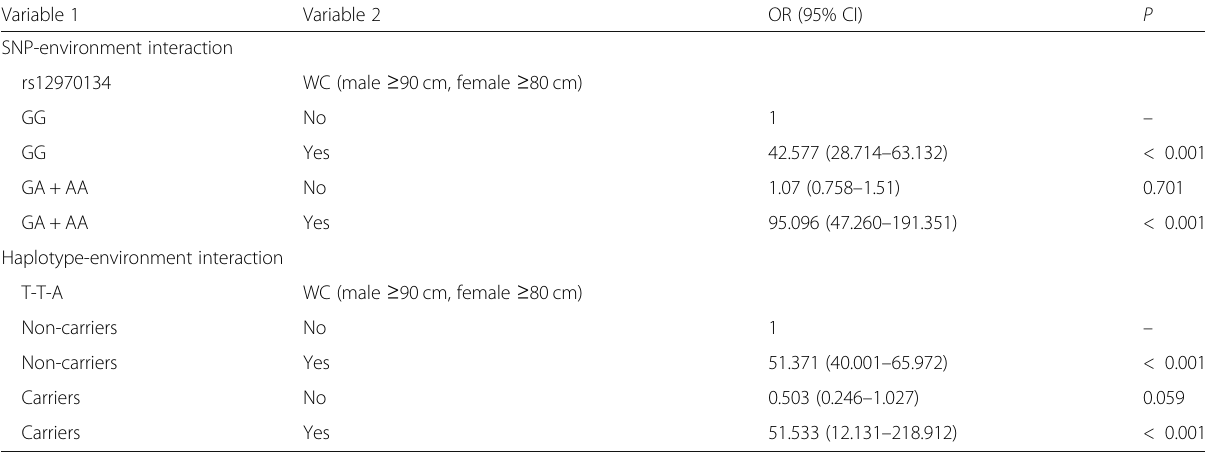
Table 6 Using logistic regression to analyze different types of interactions Variable